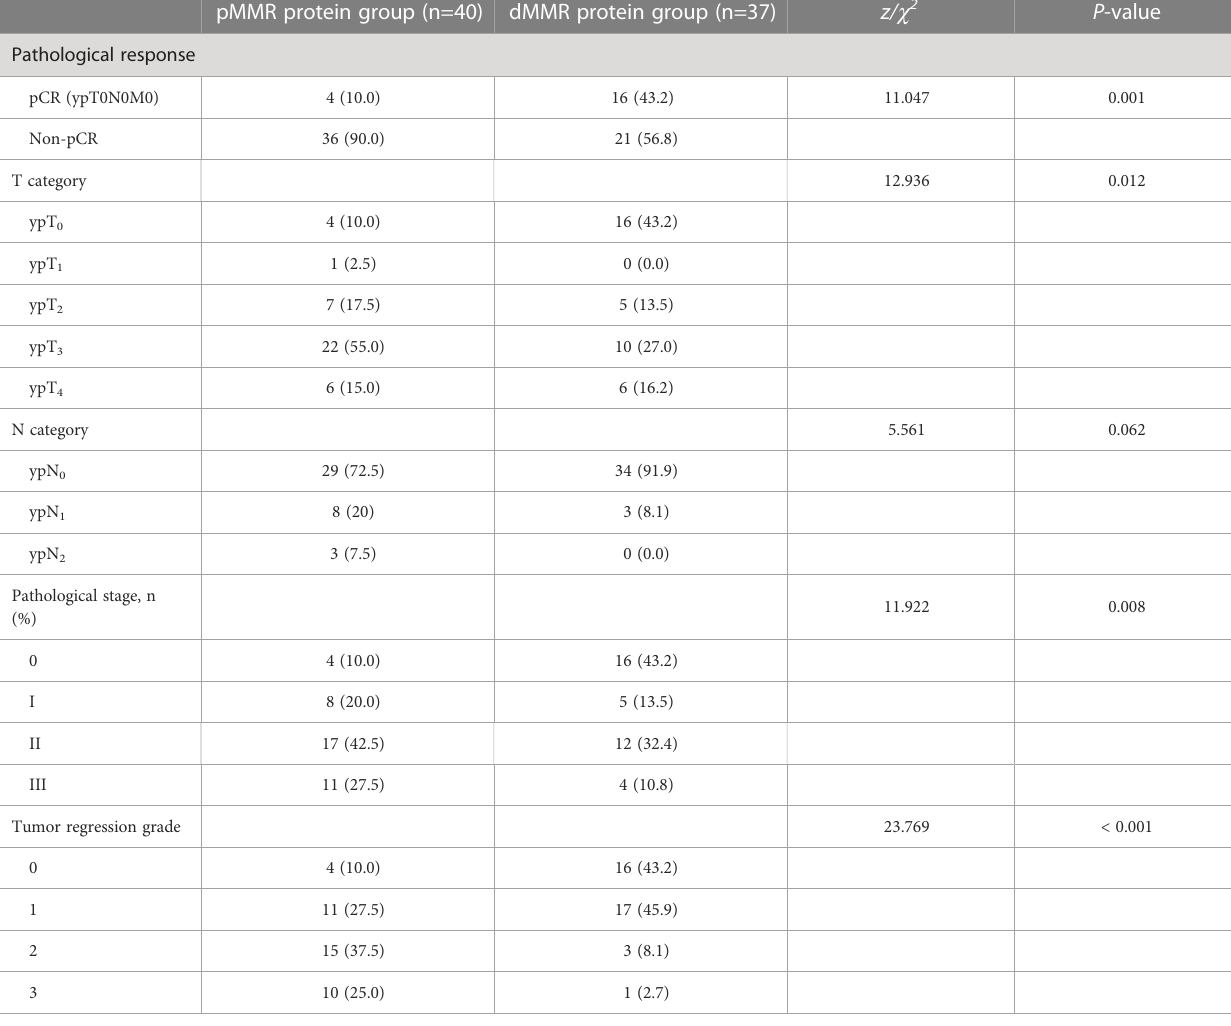
TABLE 3 Comparison of pathological response between the two groups (%).